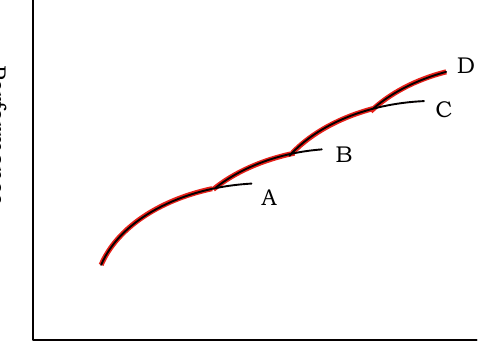
Figure 1. Trajectory-sustaining innovation (red